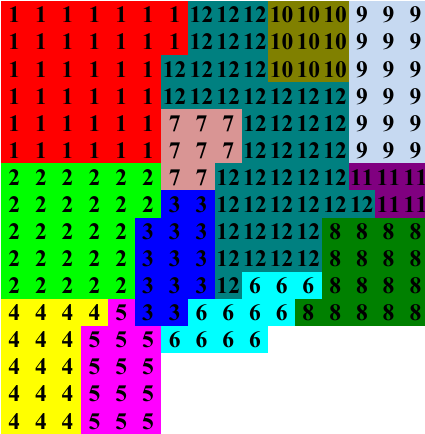
Fig. 11. The best solution obtained by CRAFT algorithm of Francis et al. (1974) for Problem 2